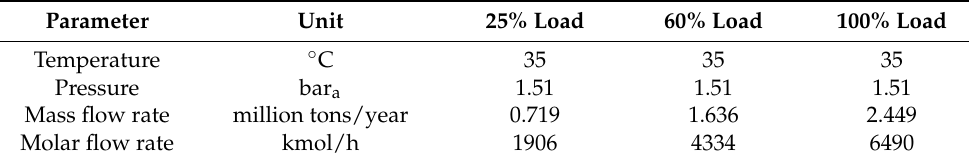
Table 8. Inlet gas flow parameters vs. plant